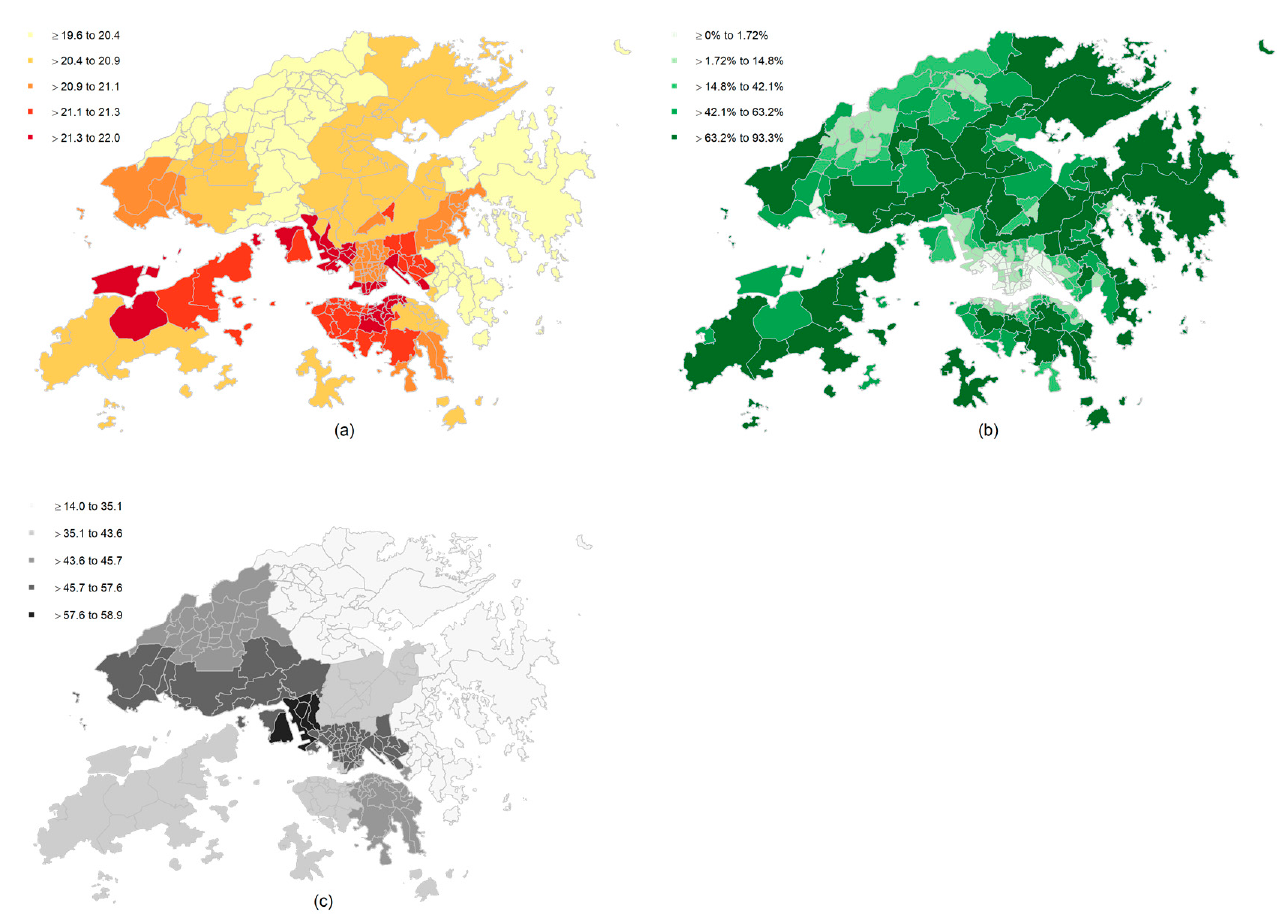
Figure 2. Environmental exposures in Hong Kong in 2016. Note: ( a ) minimum temperature (°C); ( b ) green space density (%); ( c ) NO 2 (µg/m 3 ).